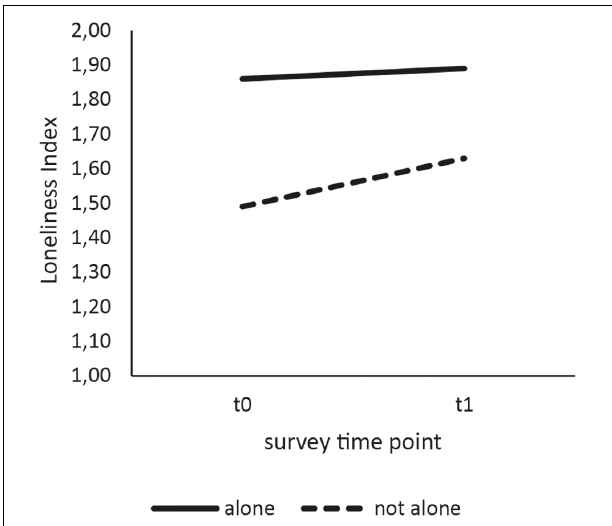
FIGURE 3 | Differences in reported loneliness between time points according to living